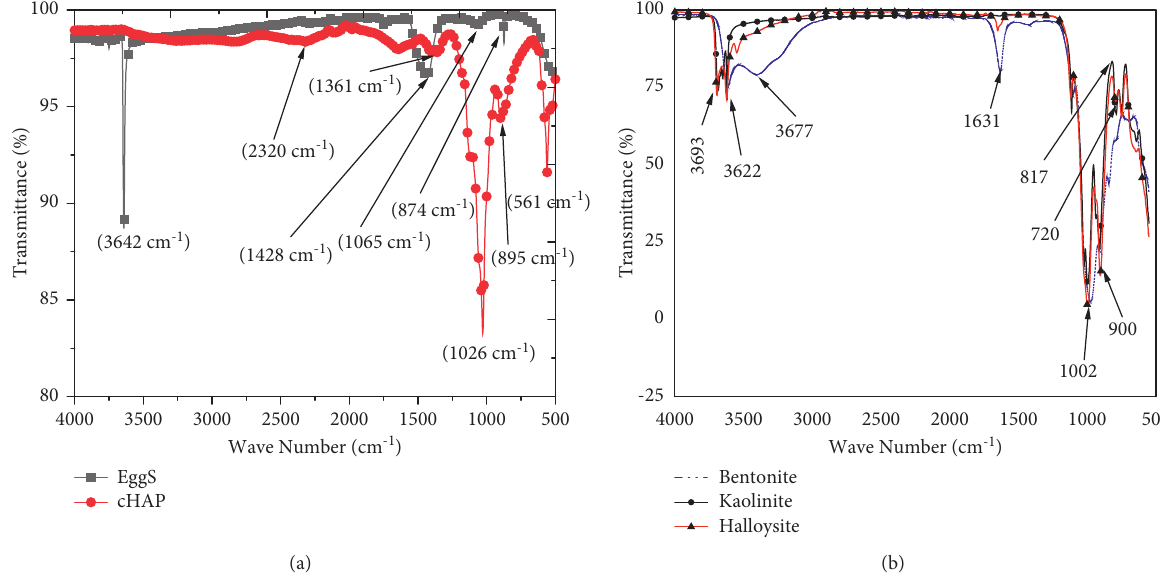
Figure 3: FTIR spectra for (a) powdered eggshells and calcined HAP and (b) HNT, KAO, and BENT.